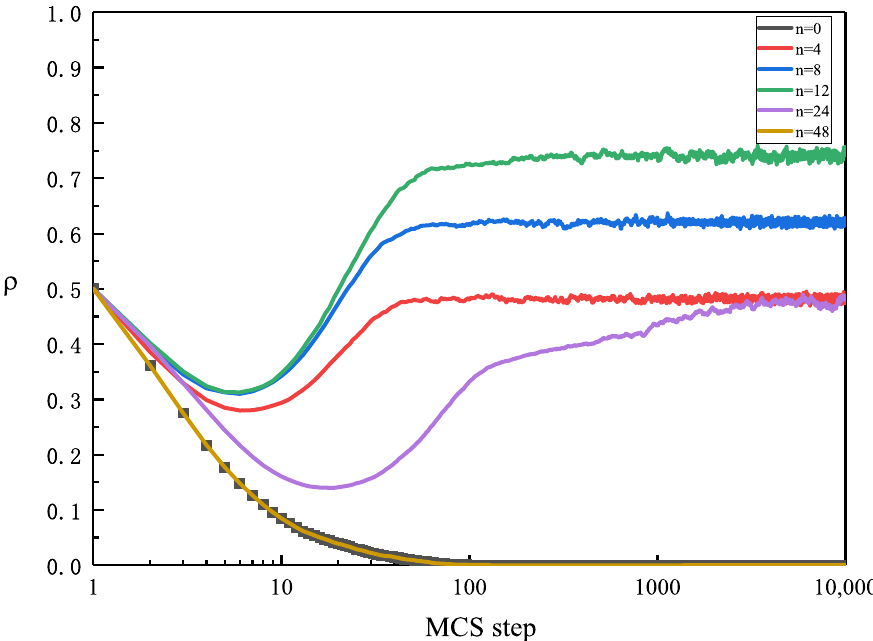
Figure 6. Fraction of cooperators as a function of time step when the amount of information available to individuals varies. In all simulations, the system setup is assumed to be L × L = 100 × 100, q = 0.5, c = 0.1, T = 1.1 and the noise factor is set to be K =